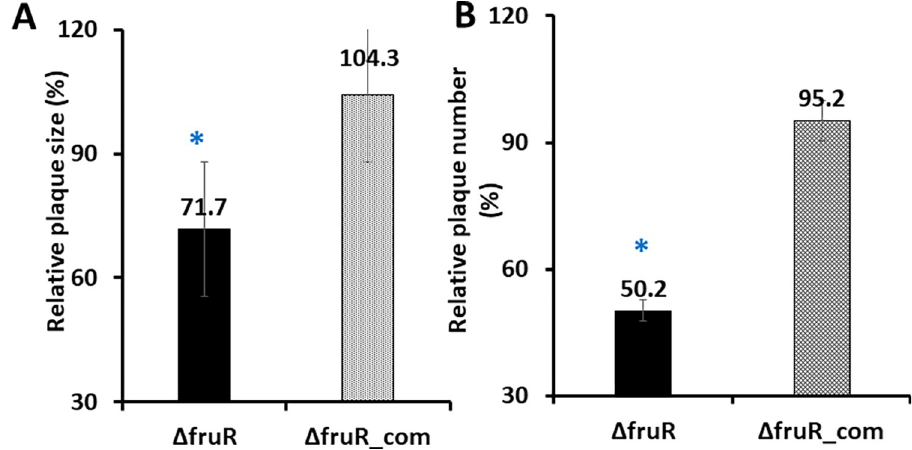
Fig 2. The Δ fruR strain has decreased plaque size and numbers in L2 fibroblast monolayers compared to wildtype and complemented Δ fruR ( Δ fruR_ com). (A) Relative plaque size is based on the percent plaque size compared to wildtype. (B) Relative plaque number is based on percent plaque number compared to wildtype. Monolayers of L2 fibroblasts were infected with the indicated strains, and plaque number and size were determined at 96 hours post infection. The experiment was repeated 3 independent times. At least 10 plaques were measured each time. Error bars represent the standard errors of the means and asterisks ( � ) indicate statistical significance (P < 0.05) by two-tailed Student’s t test compared to